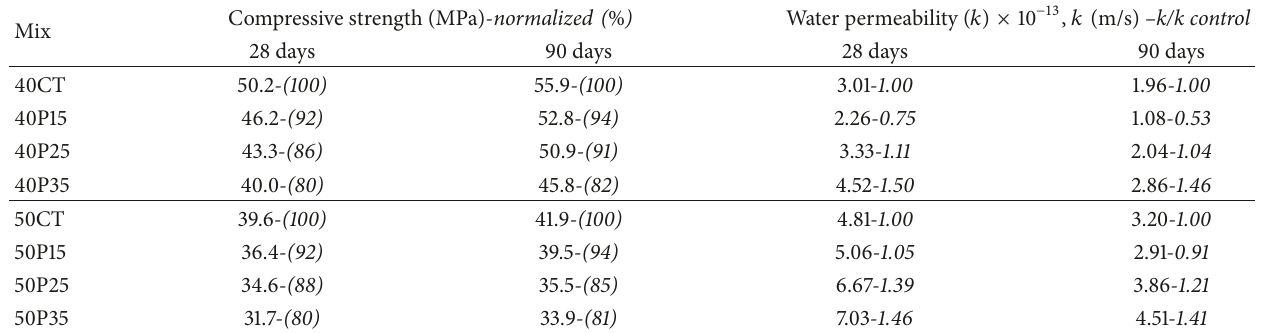
Table 4: Compressive strengths and water permeability coefficients of the types of concrete at 28 and 90